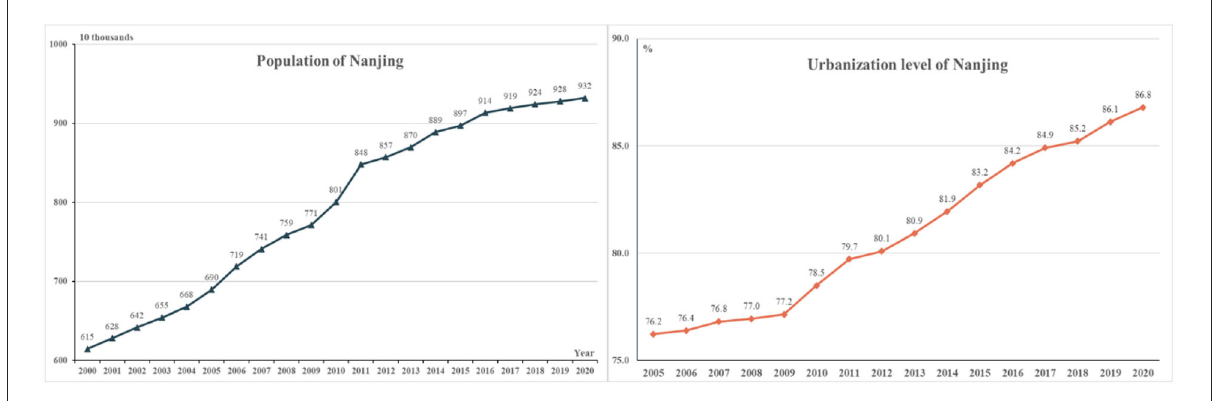
FIGURE3 The Population and urbanization level of